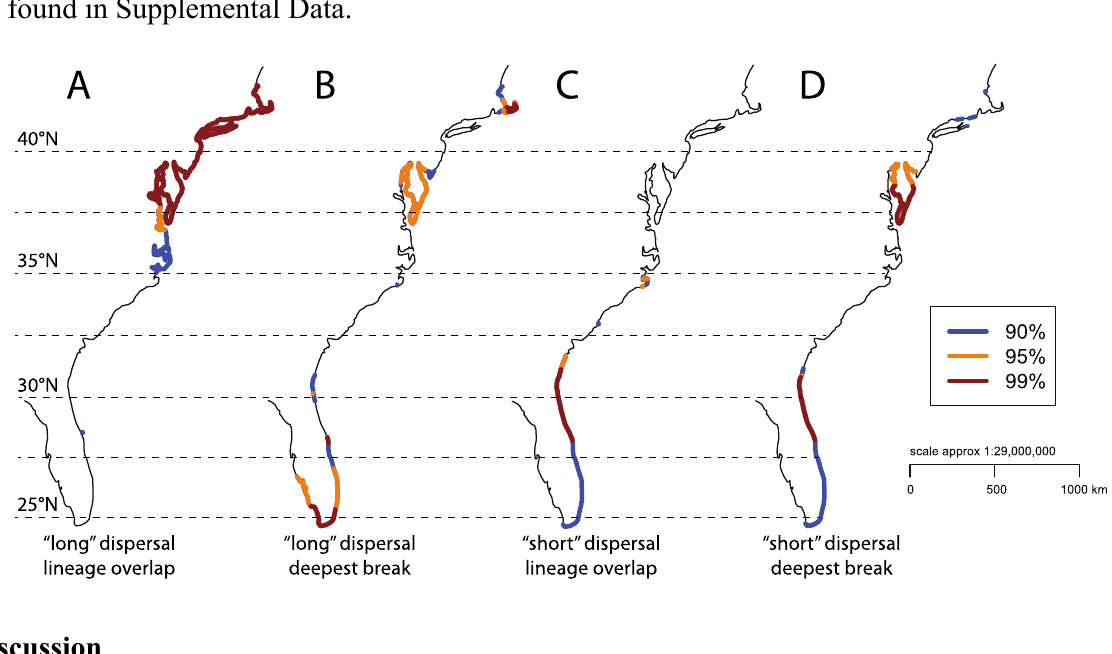
Figure 2. The Atlantic coast of North America, with coincidence of phylogeographic breaks indicated for regions that have more observed transitions than 90, 95, or 99% of location-bootstrapped ―null‖ distributions. Results vary for ―long‖ dispersing species ( A , B ; 22 species) depending on whether the overlap of lineages ( A ) or deepest phylogeographic break ( B ) is analyzed. Similarly, results differ for ―short‖ dispersing species ( C , D ; 11 species) depending on whether the overlap of lineages ( C ) or deepest phylogeographic break ( D ) is analyzed. Sampling effort and taxa included in each plot are found in Supplemental